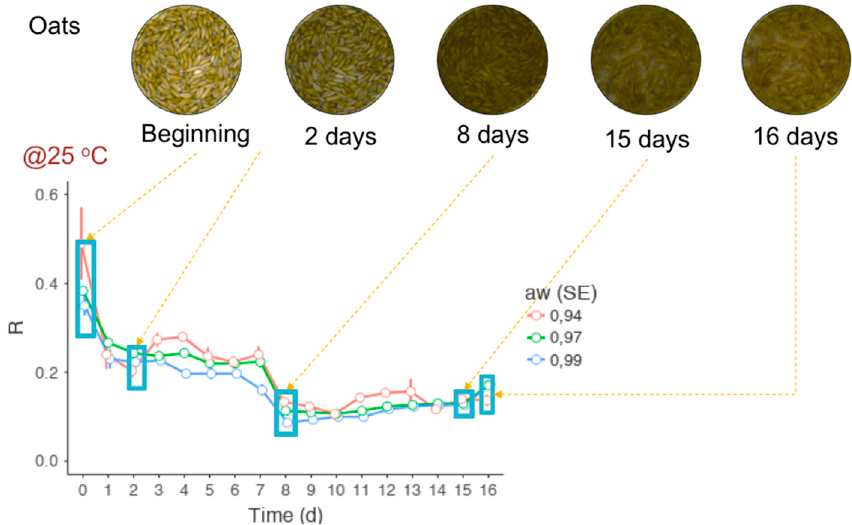
Figure 4. Red color variation of F. graminearum -contaminated oats over 16 days. Note that the color variation was similar, regardless of a w .